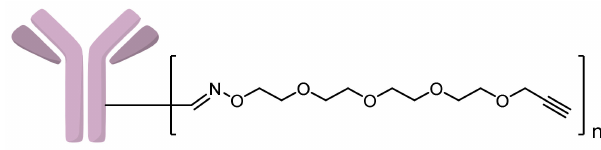
Figure 11. The structure of conjugate 9 . Conjugate 13 The 6H8 antibody (1.07 mg, 7.1 nmol) was modified with reagent 12 according to general procedure A; 0.25 mg (1.7 nmol, 23%) of conjugate 13 (Figure 12) with an average degree of labeling of 2.5 were obtained.